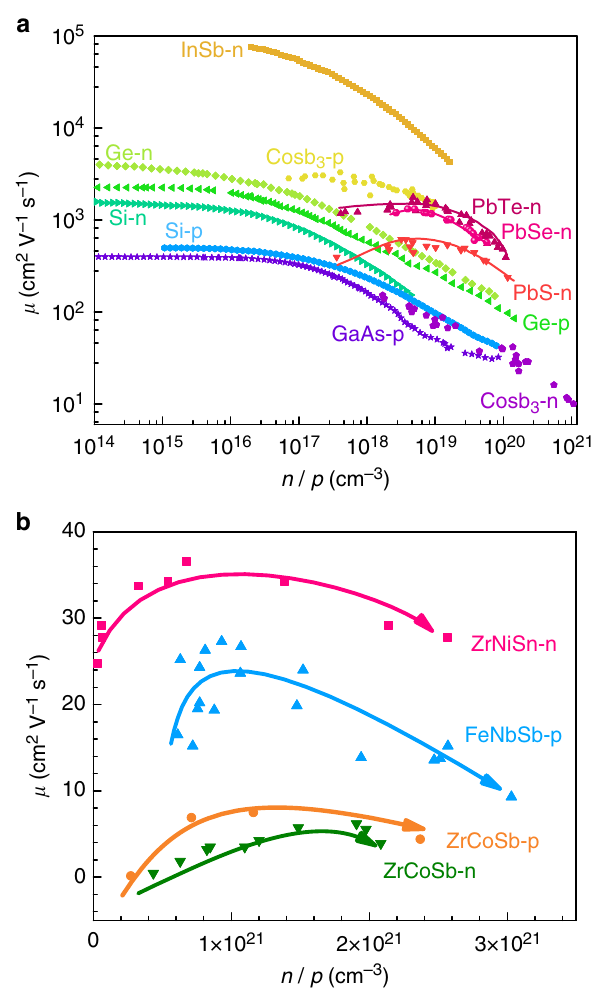
Fig. 1 Room temperature carrier mobility versus carrier concentration n / p . a Some selected TE semiconductors 15,28 – 31 , and b several half-Heusler TE compounds 40 – 43